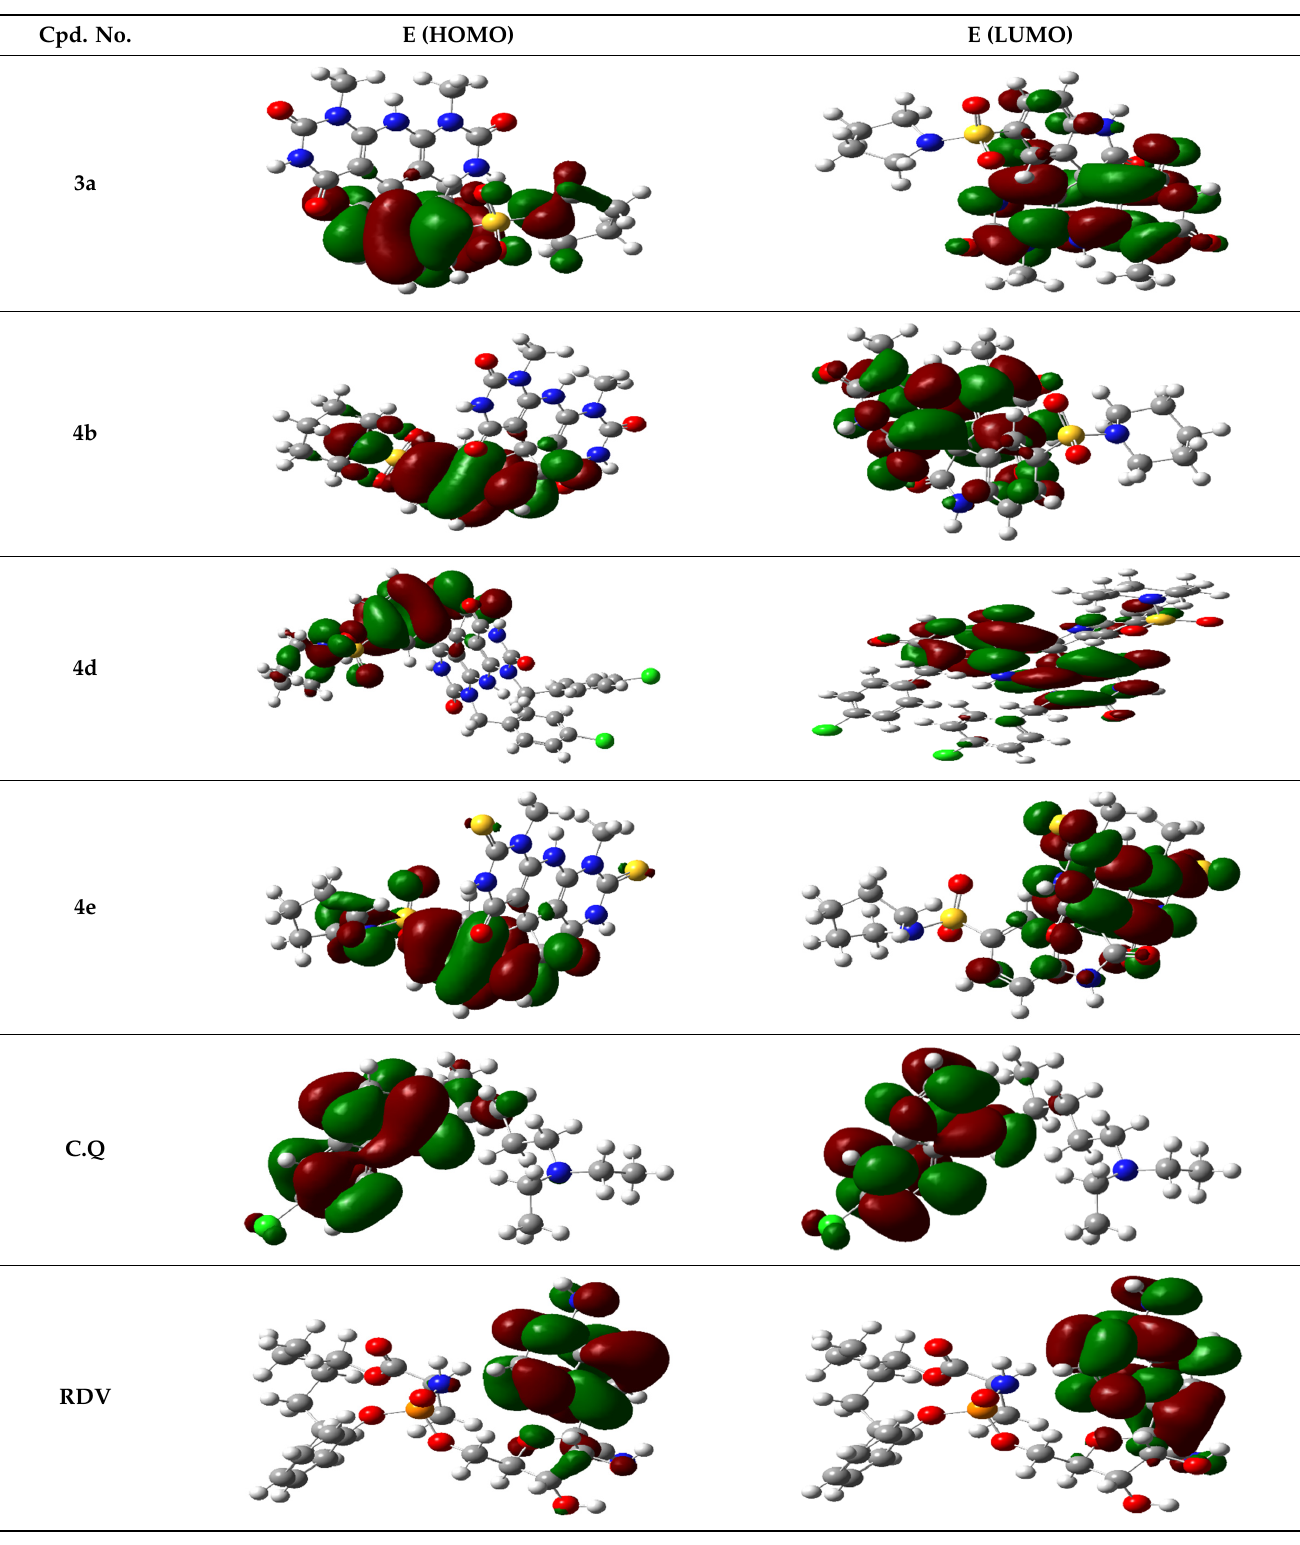
Table 6. The highly occupied and lowest unoccupied molecular orbitals of the most active derivatives 3a , 4b , 4d , 4e and positive control ( Chloroquine and Remdesivir ). Cpd. No.